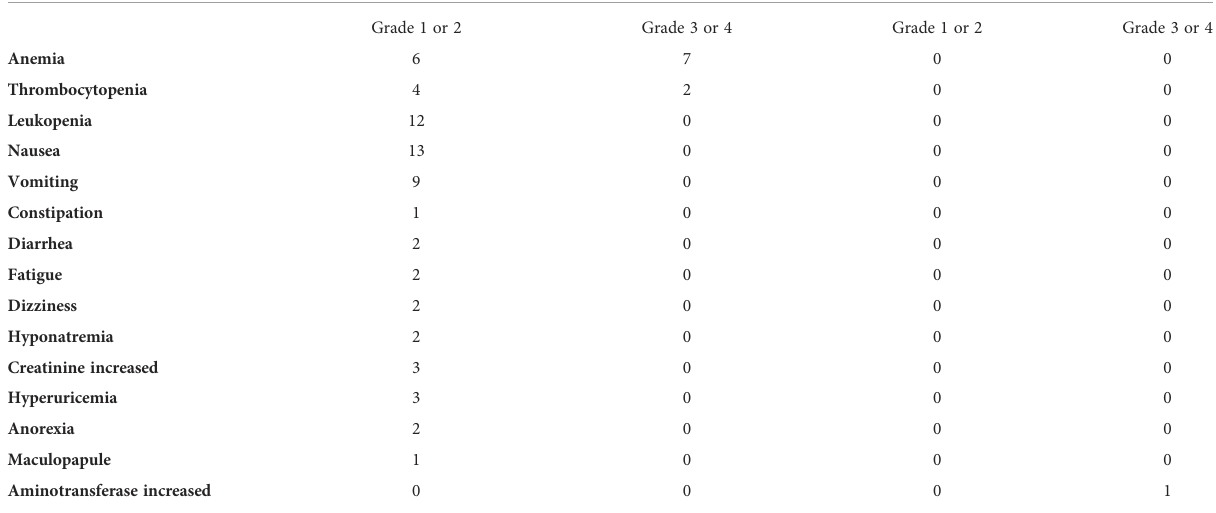
TABLE 2 Treatment related